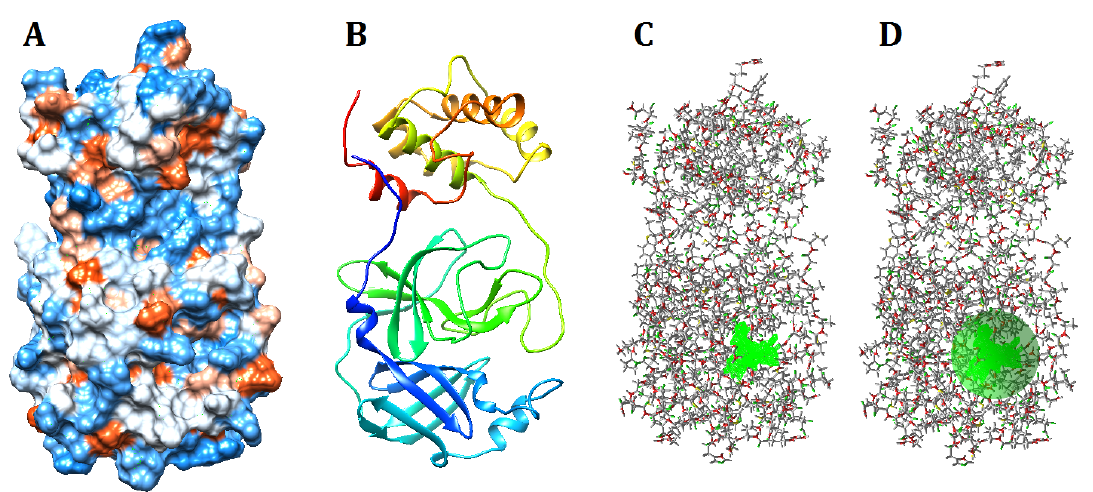
Visualization using UCSF Chimera